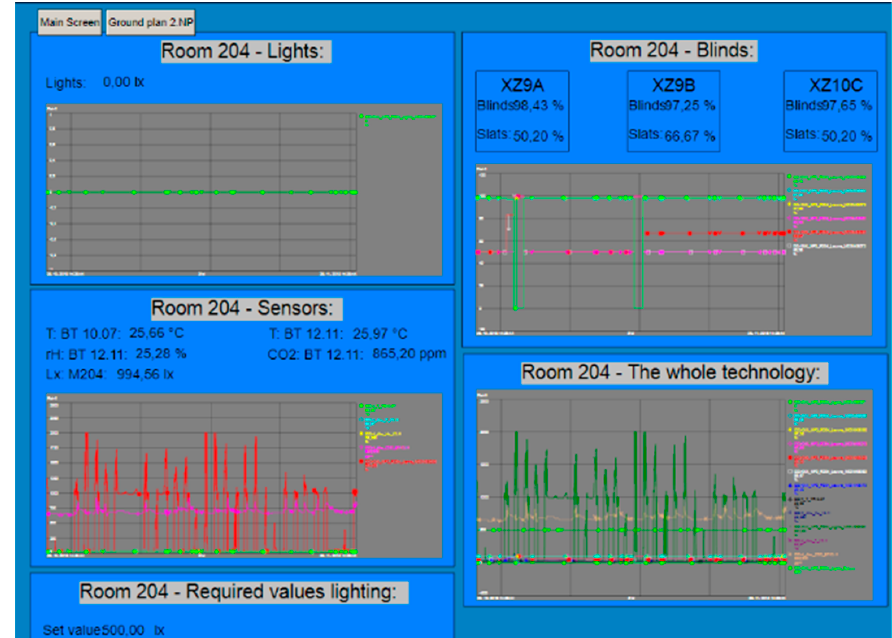
Figure 3. A screen for room 204 with a detailed description of individual technologies and individual charts in SW tool PI ProcessBook.